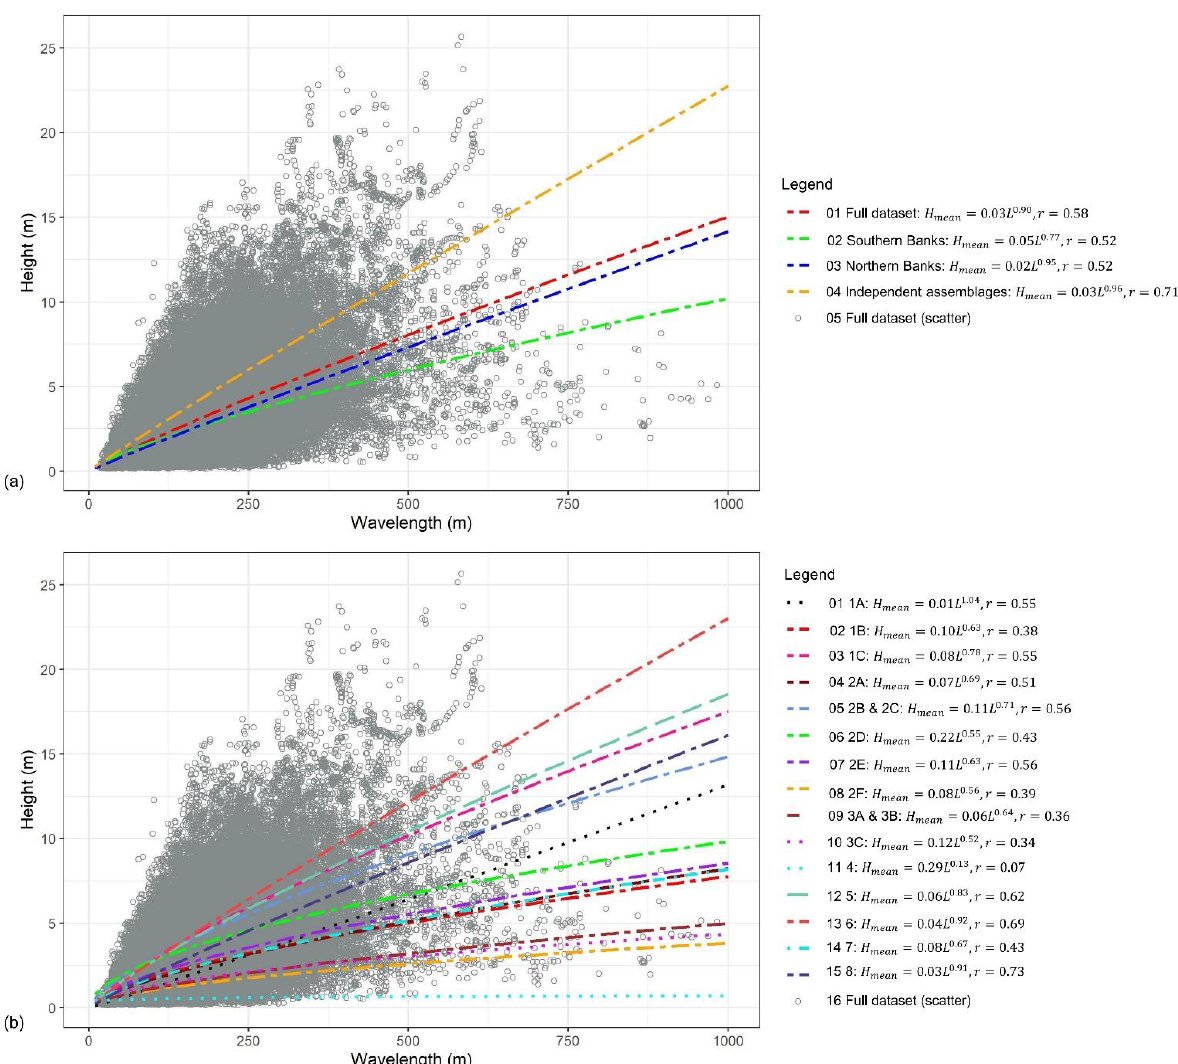
Figure 6. Relationship between sediment wave heights and wavelengths in the south-western Irish Sea: ( a ) displays the results for the full dataset and for three compiled environments i.e., Southern Banks, Northern Banks and Independent Assemblages, and ( b ) displays the results for each individual study site.